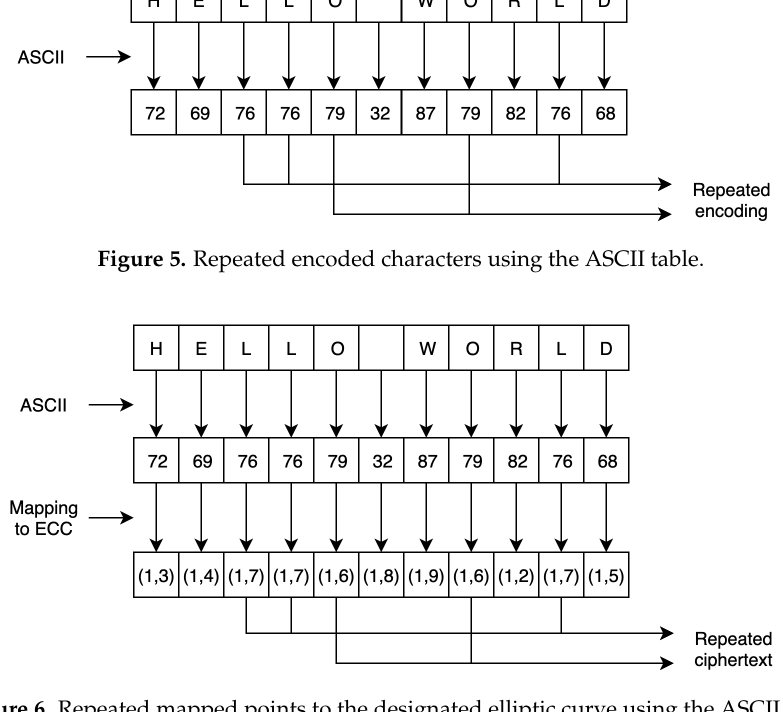
Figure 6. Repeated mapped points to the designated elliptic curve using the ASCII